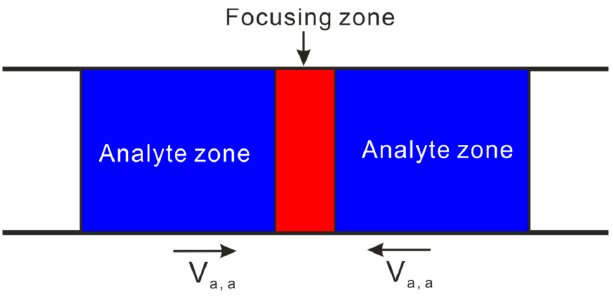
Figure 4. Schematic illustration showing of the gradient focusing mechanism. The analyte accumulates with a velocity of V a,a towards the stationary focusing zone from two analyte zones. with a velocity of V a,a towards the stationary focusing zone from two analyte